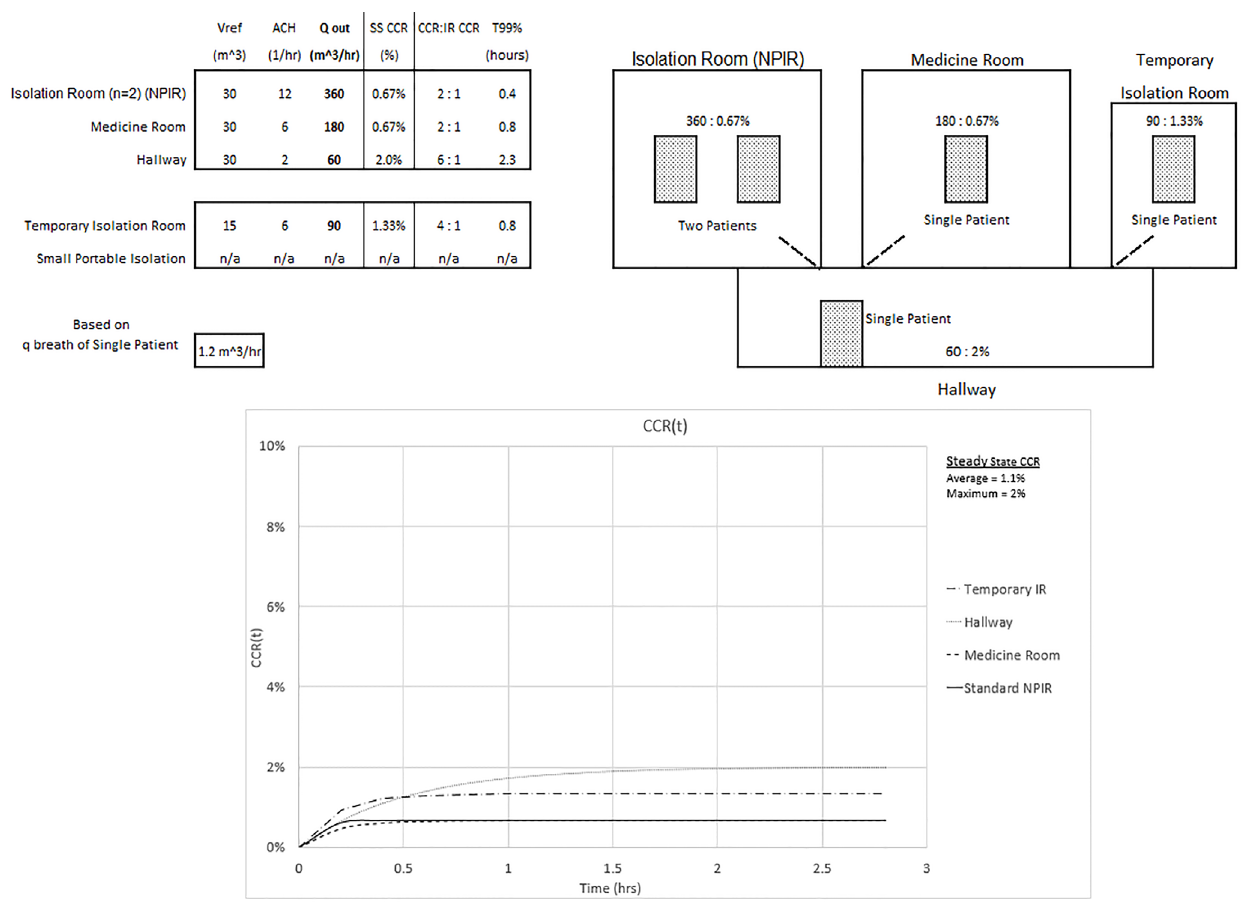
Figure 5. Configuration and CCR(t) of steady state average and maximum CCR exposures of 1.1% and 2% for equal time with all patients (average is three times the exposure of a standard isolation room CCR of 0.33%). NPIR, negative pressure isolation room; SS, steady state; CCR, contaminant concentration